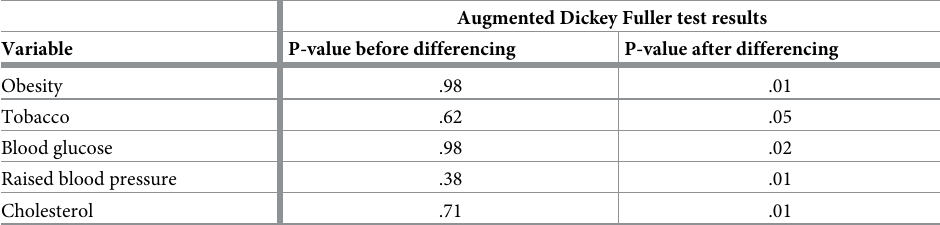
Table 2. Augmented Dickey Fuller test